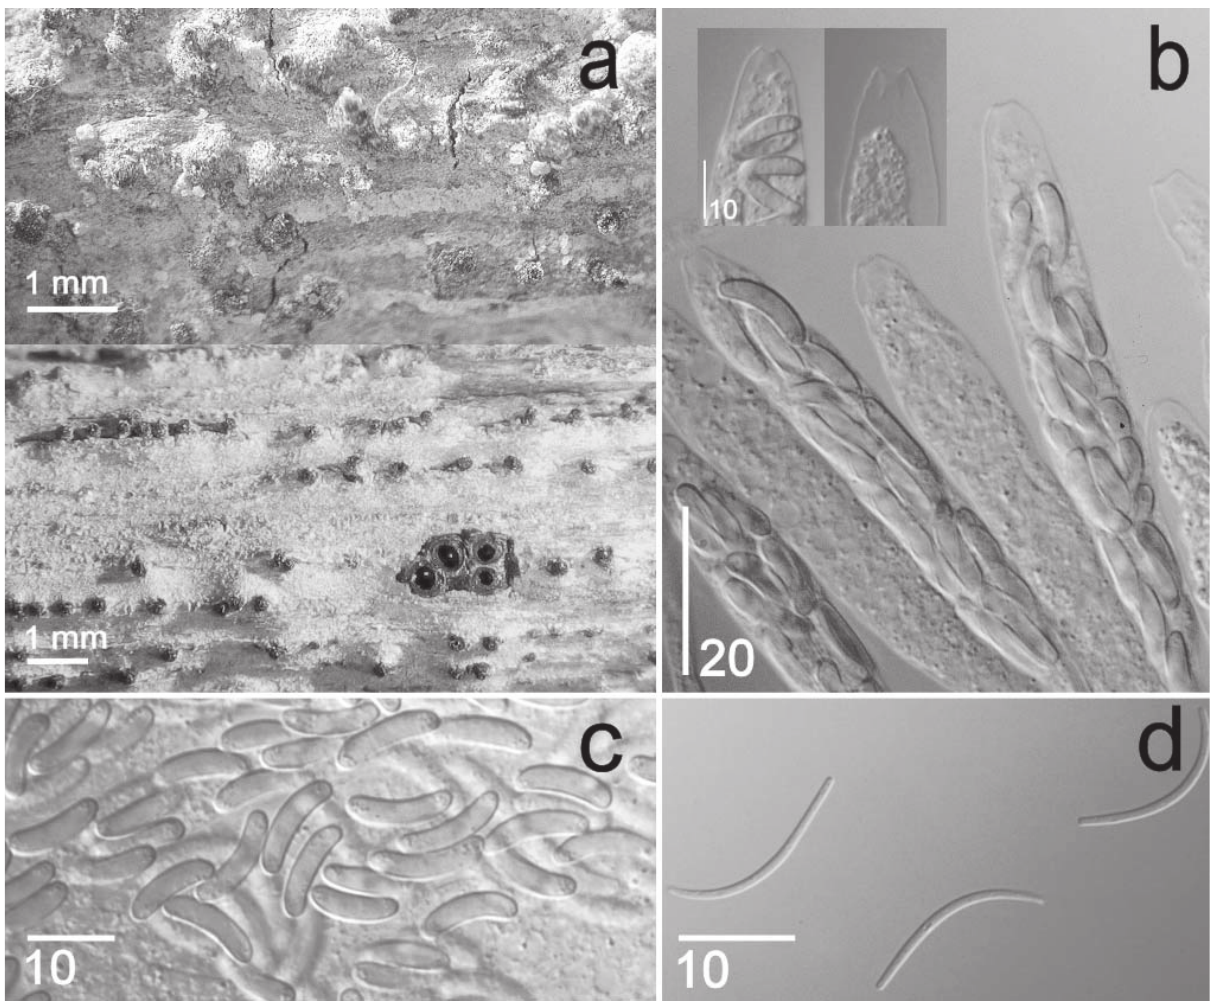
Fig. 1. Cryptovalsa ampelina . a) Erumpent perithecia on grapevine canes. b) Asci and ascus tips (insert). c) As- cospores. d) Conidia. Scale bars in µm, except in 1a